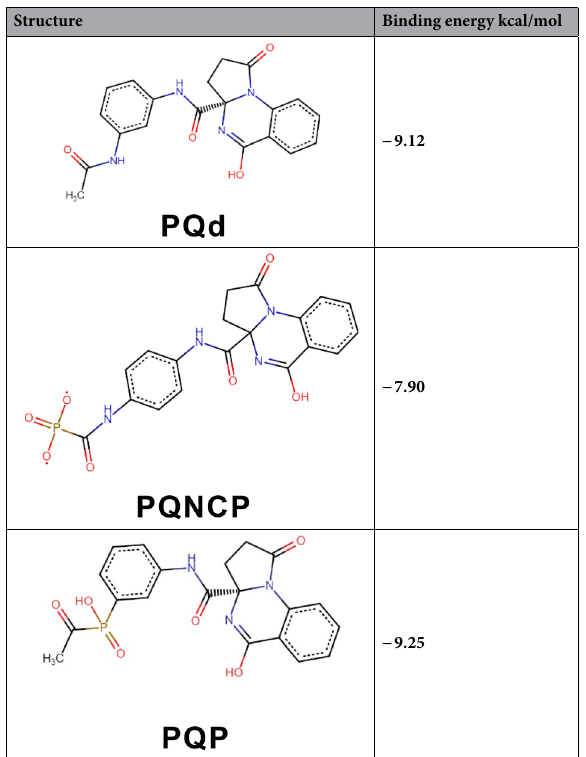
Table 1. Chemical structures and binding energies of PQd and its derivatives. The binding energies were calculated with LeDock. The names of the compounds, PQNCP and PQP were assigned arbitrarily based on the position of the phosphate group substituted in the acetamidophenyl